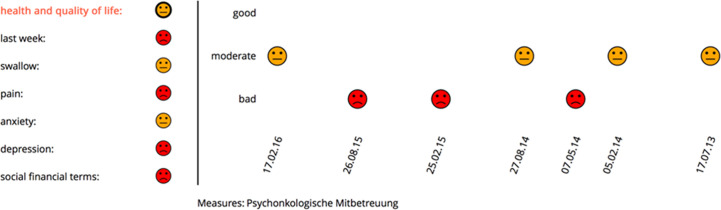
New visualization realized with face-like icons. A red icon indicates problems and a need for attention, a yellow icon, a moderate condition of the patient, and a green icon in a good situation. In this case, psycho-oncological support was started concerning many problematical findings in the problem field health and quality of life.